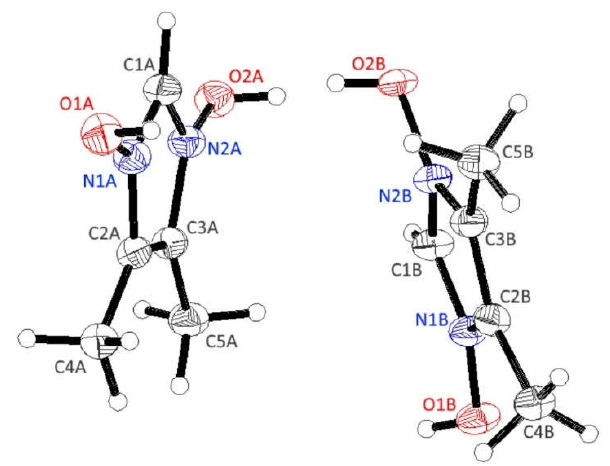
Figure 10. Ortep drawing of the independent unit with a numbering system for HIMO; the position of the hydrogen atom is averaged between both oxygen acceptors at two locations with half